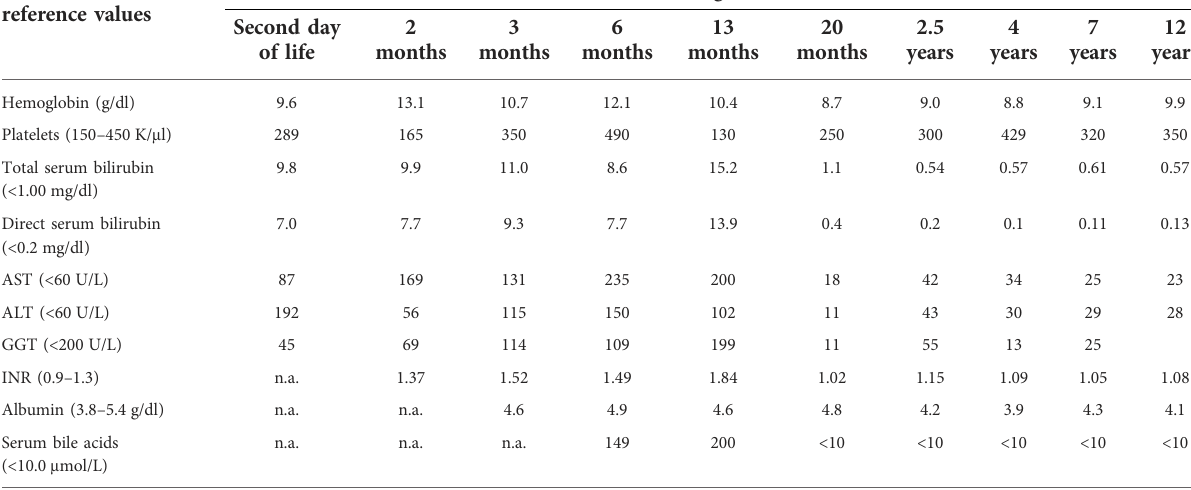
TABLE 1 Results of laboratory